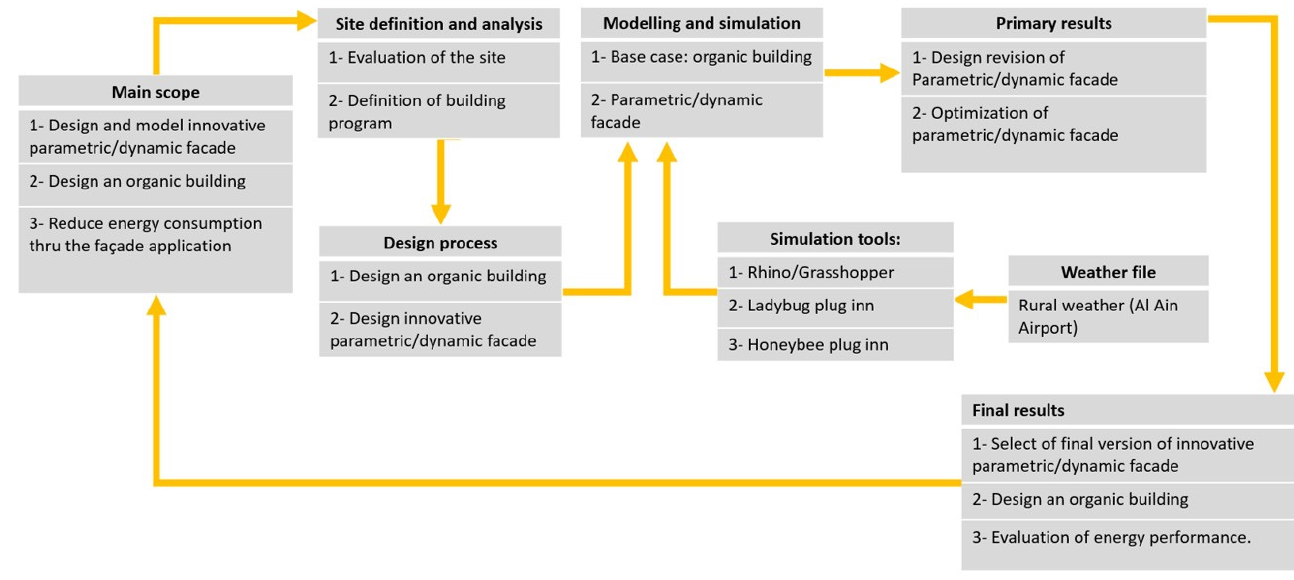
Figure 1 . Methodology in a schematic view. Figure 1. Methodology in a schematic view.